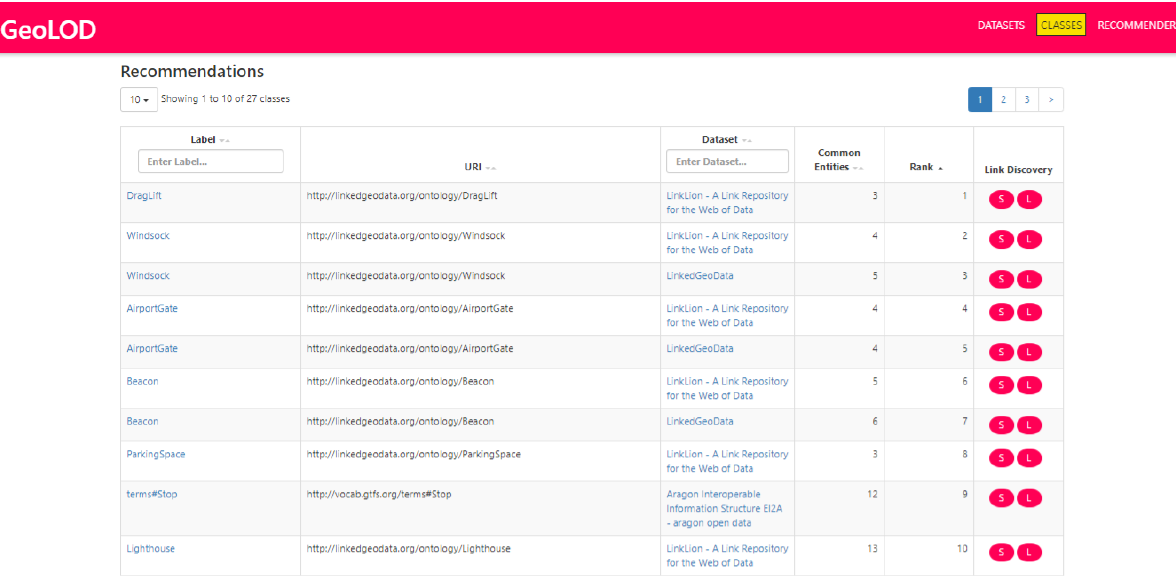
Figure 5. The ranked class recommendations list for the Point class of the AEMET